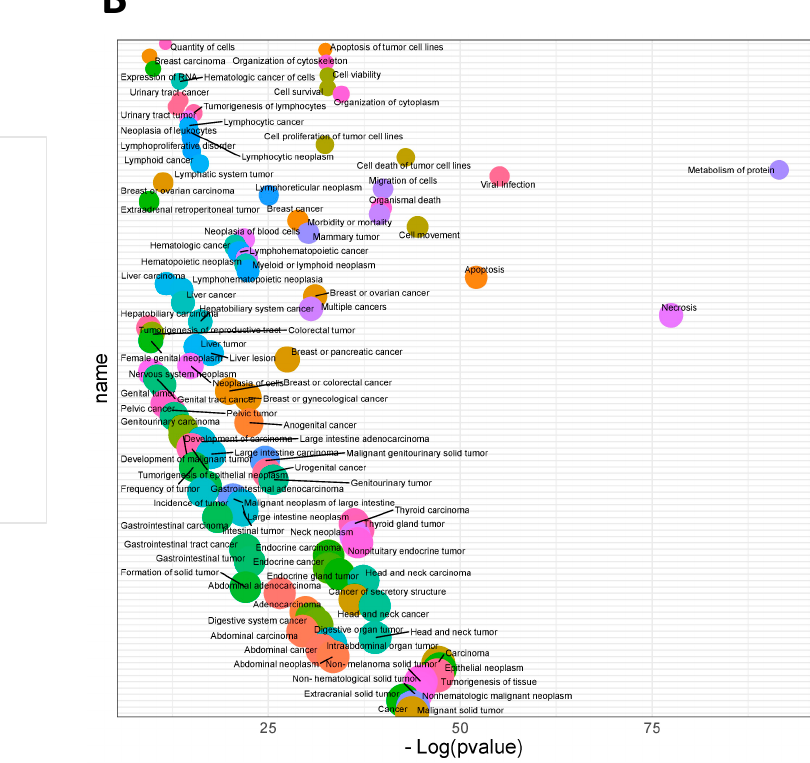
Figure 1. MIA-PaCa2 CM protein expression profile. ( A ) Subcellular localization of proteins identified in MIA-PaCa2 CM represented by pie chart. ( B ) Biological processes associated with proteins identified in MIA-PaCa2 CM represented by bubble plot. Ingenuity pathway analysis was used to categorize the proteins based on their functional